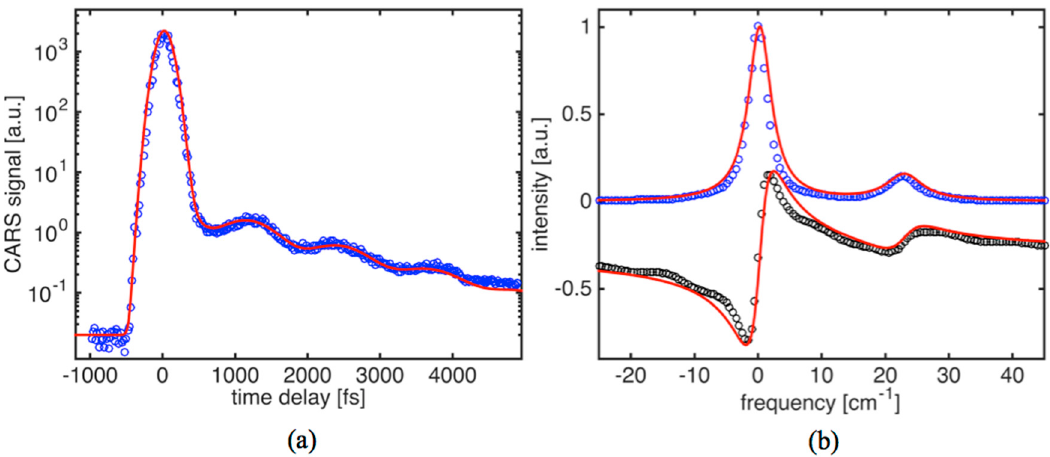
Figure 4. ( a ) CARS transients (open circles) measured in olive oil while vibrations at ≈ 1072 cm − 1 were driven and probed. The best fit to the data is given by the solid red line for which Equations (3) and (4) have been employed. Corresponding line component parameters are listed in the text; ( b ) The real (black circles) and imaginary (blue circles) parts of χ (3) ( ω ) obtained using experimental CARS transient and Equation (5).